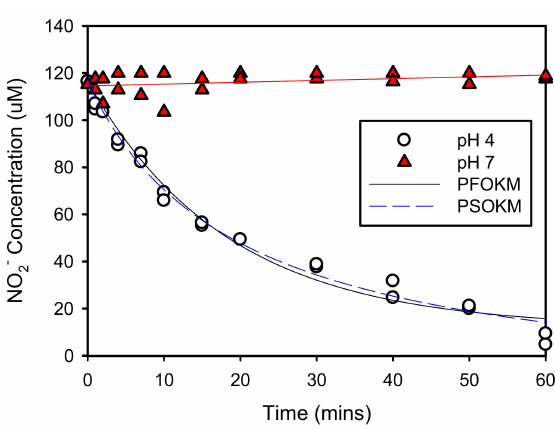
Figure 7. NO 2 − adsorption onto goethite at pH 4 and 7.